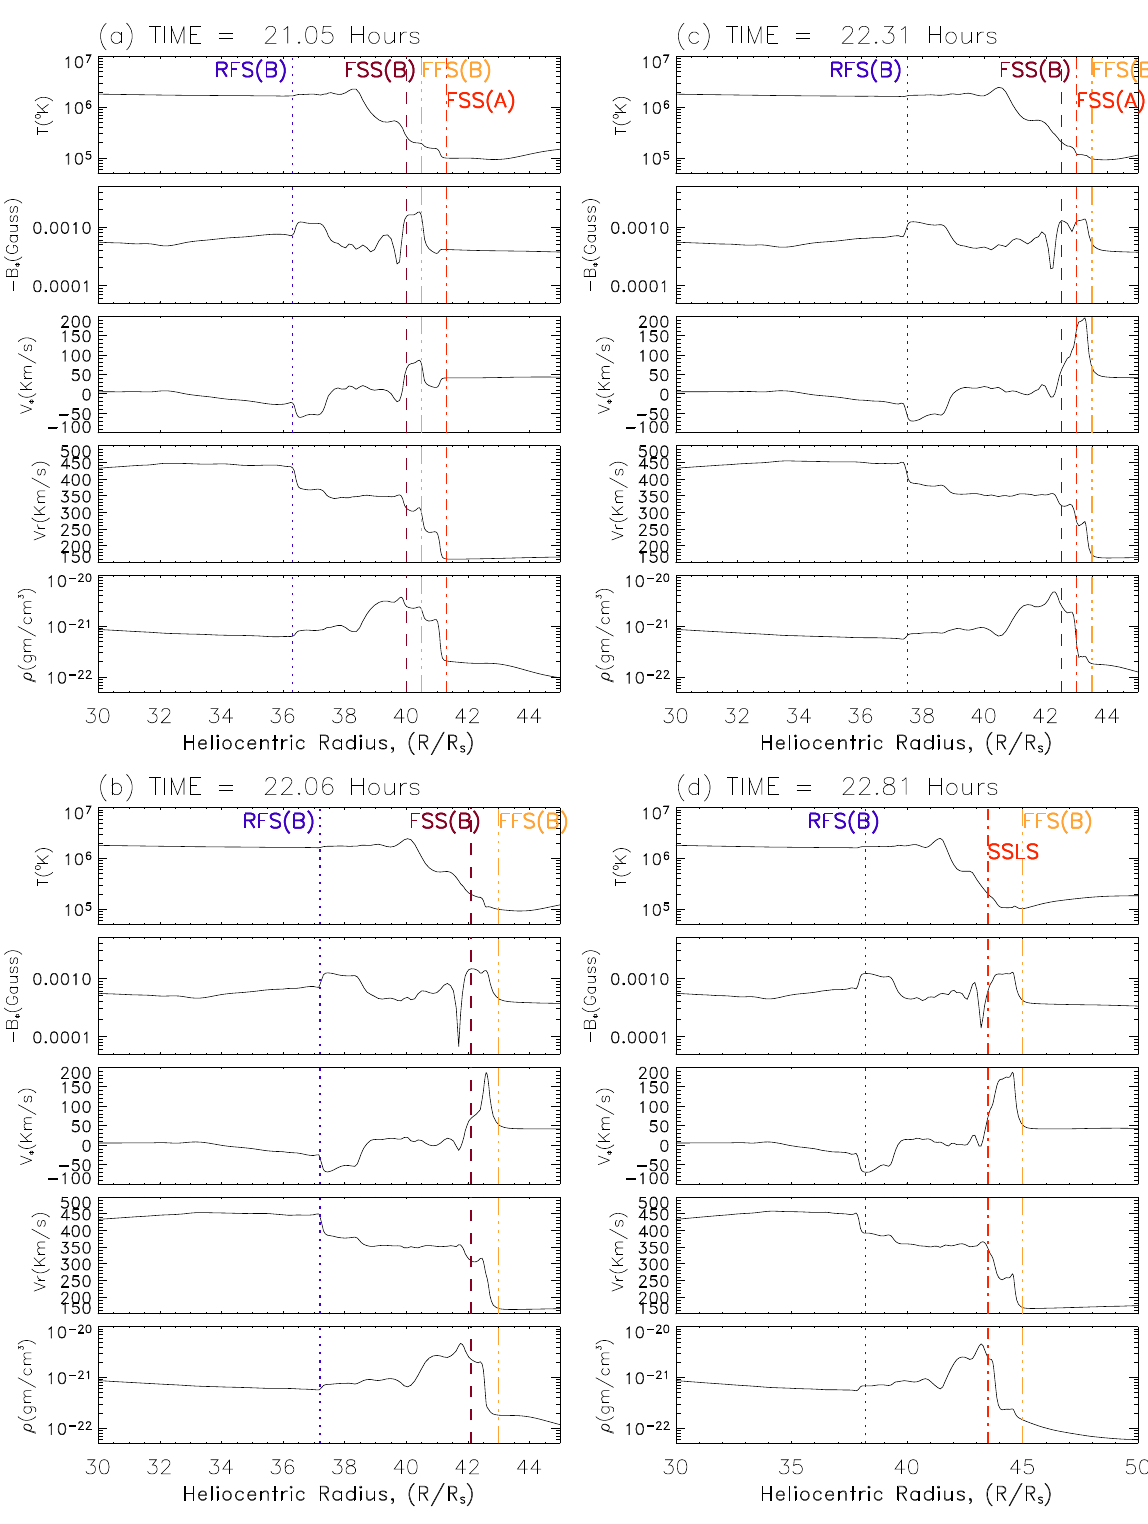
0 00 = 0 . 4 , T 0 = 0 . 4 v = 1 . 6 , T 00 = 5 . 0. (a) , (b) , (c) and (d) show the solar r r v r ◦ v r ◦ T ◦ T ◦